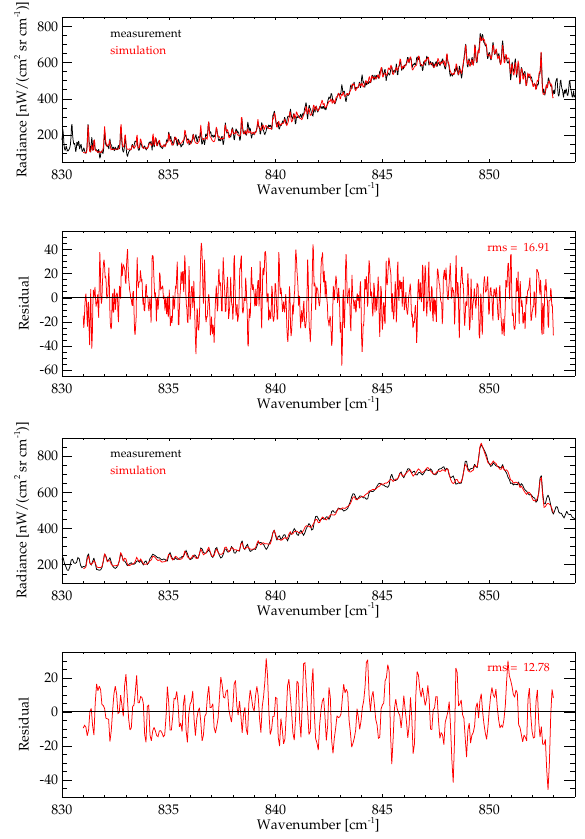
Fig. 2. Typical measured (black) and calculated (red) spectra of CFC-11 and the fit residual in 14 km in the 831 and 853 cm − 1 spectral region for the FR (top) and the RR (bottom) nominal measurement modes.